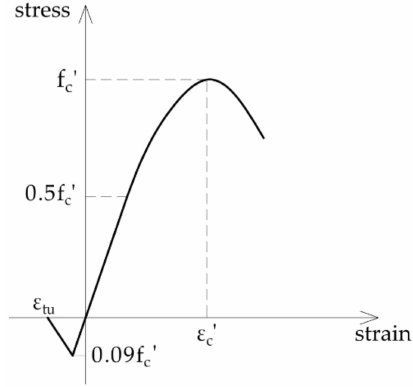
Figure 8. The constitutive model for